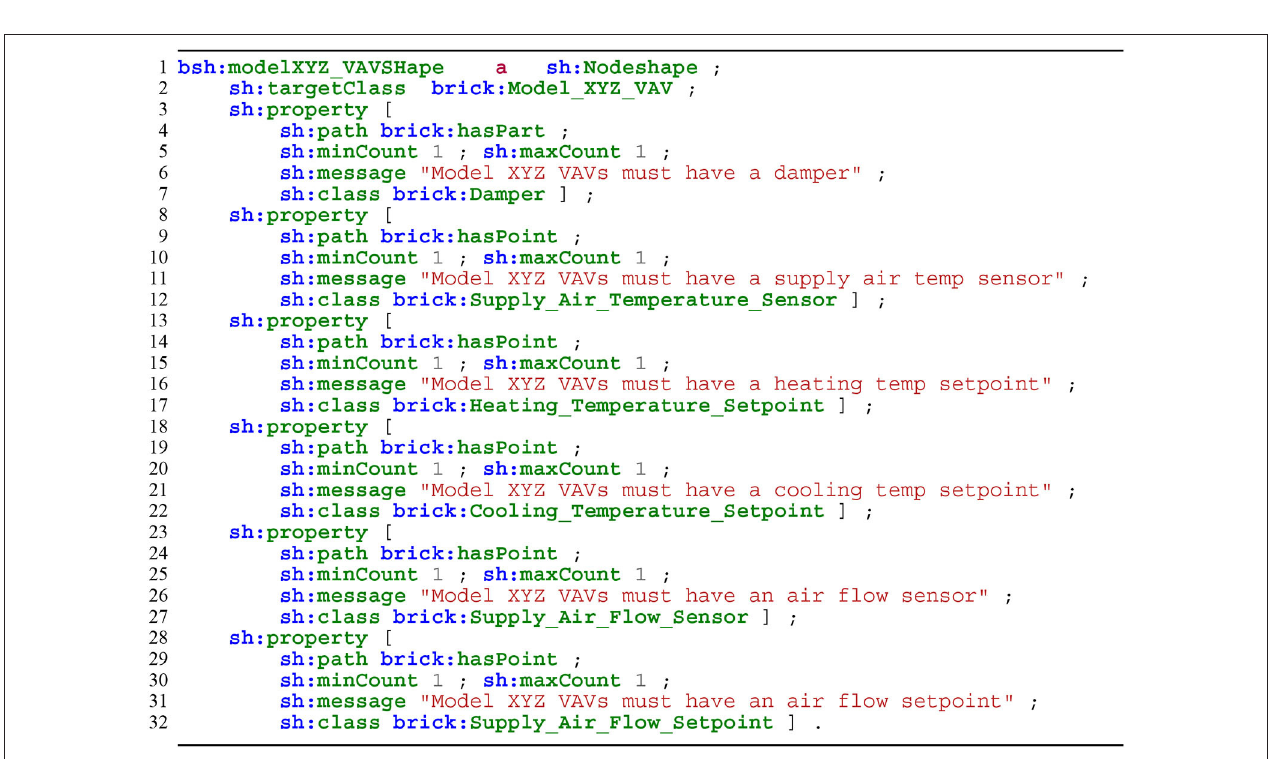
FIGURE 12 | A SHACL shape encoding the required parts and points for a theoretical “Model XYZ” variable air volume box.